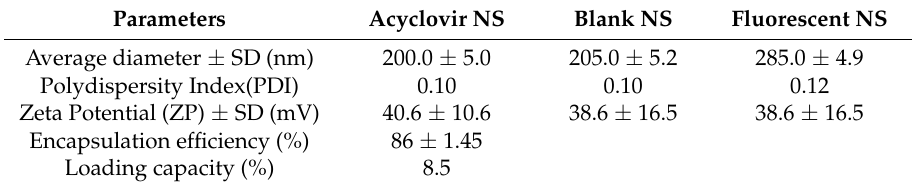
Table 1. Summary of the physico-chemical characterization of Acyclovir-loaded chitosan nanospheres (NS), blank NS, and fluorescent NS. PDI: Polydispersity Index; ZP: Zeta Potential.